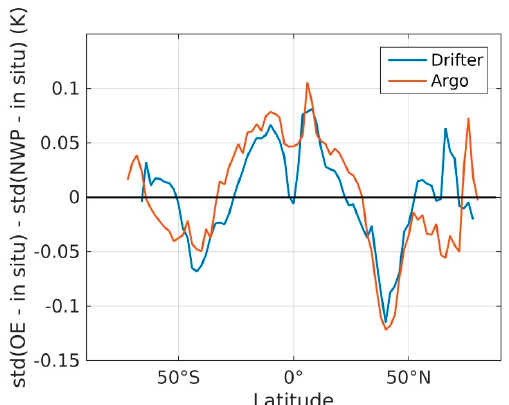
Figure 13. The latitudinal difference in standard deviations of OE and NWP SST compared against in